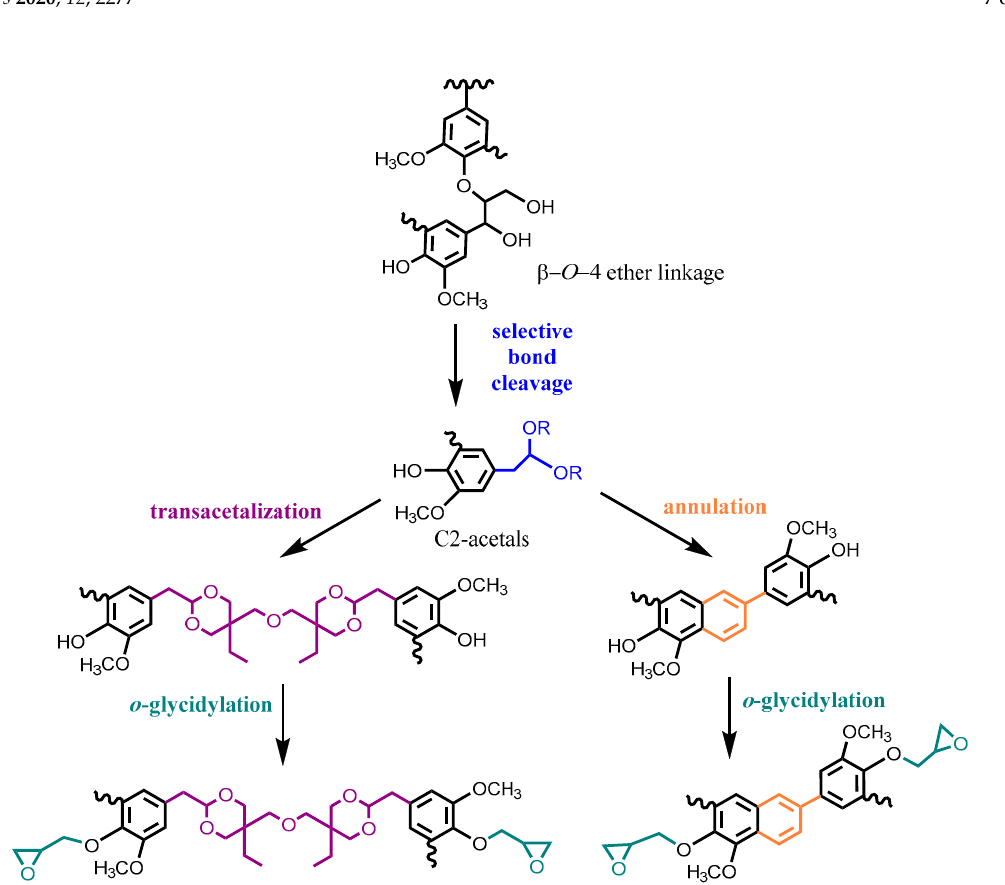
Figure 5. Synthetic scheme of lignin-based epoxy resin from selectively depolymerized lignin. Adapted from [36] with permission from The Royal Society of Chemistry © 2020.